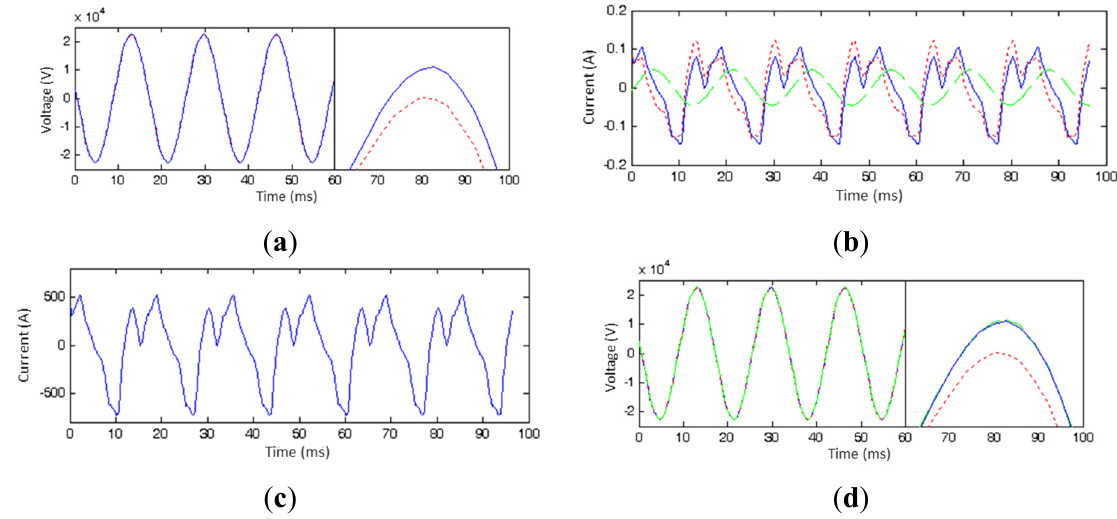
Figure 11. Results for 120% of the rated voltage: ( a ) v 1 (solid) and av 2 (dotted); ( b ) i 0 (solid), i m (dotted), and i c (dashed); ( c ) v p ; and ( d ) v 1 (solid), av 2 (dotted), and v comp (dashed).